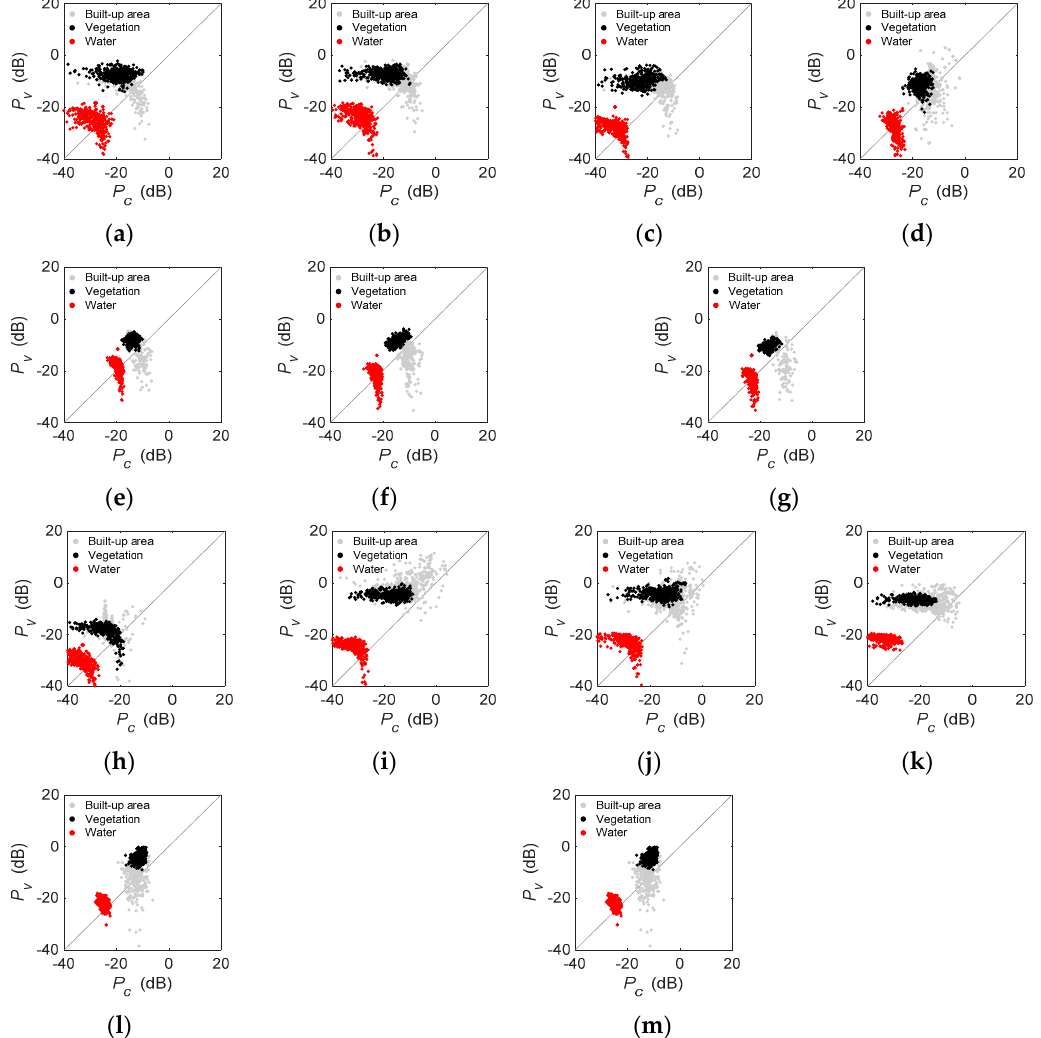
Figure 9. Scatter diagrams of built-up areas, vegetation, and water in volume and helix powers. ( a ) GF-1703, ( b ) GF-1710, ( c ) GF-1712, ( d ) R2-0903, ( e ) A2-1603, ( f ) A2-1610, ( g ) A2-1612, ( h ) GF-1702, ( i ) GF-1705, ( j ) GF-1708, ( k ) R2-1607, ( l ) A2-1504, and ( m ) A2-1601.